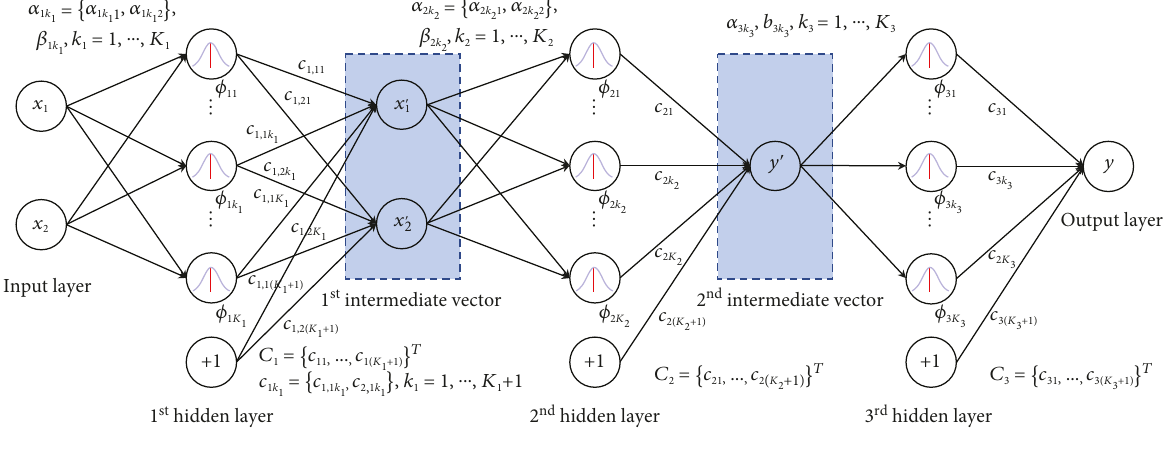
Figure 2: Proposed ML-RBF-ELM architecture.